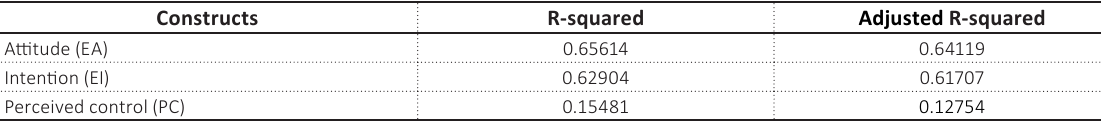
Table A4. Coefficient of determination (R-squared)